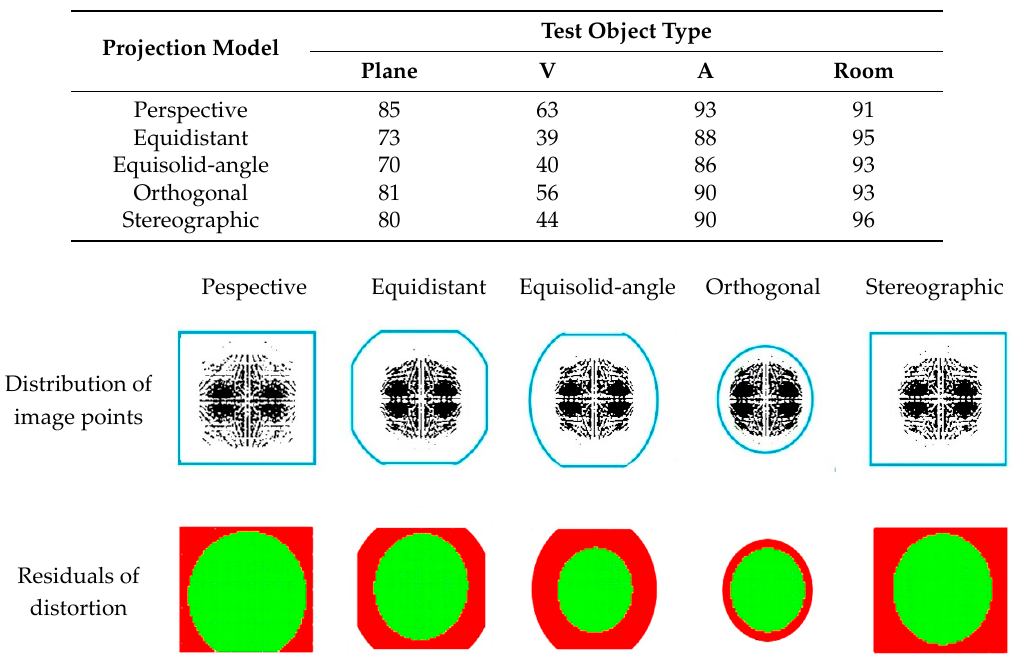
Table 13. Coverage ratio of image points (mean, %).